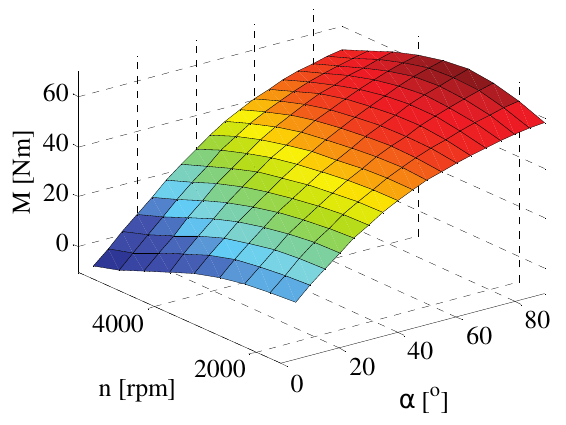
Fig. 2. Engine torque characteristic in static states